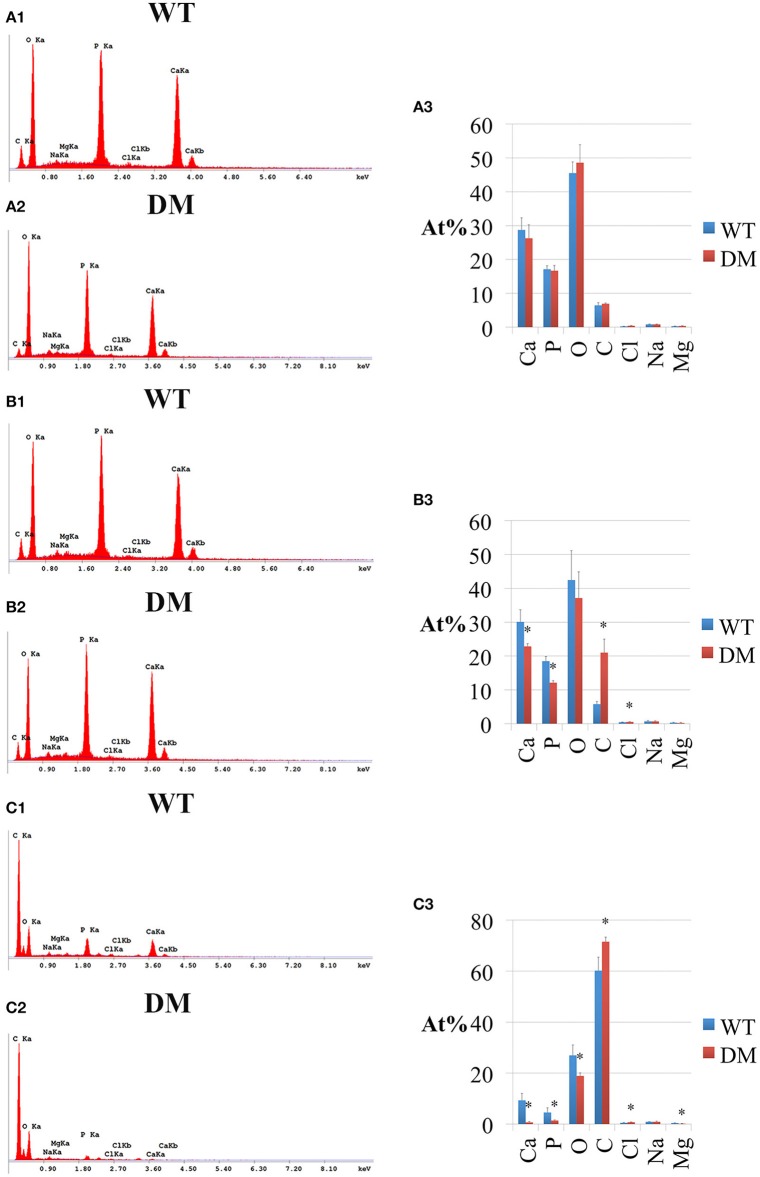
EDS analysis of enamel in wild-type and double-mutant mandibular incisors. WT, Wild-type; DM, Double-mutant; At%, Atomic percentage. (A1,A2) EDS spectrum of enamel at the first reference plane. (A3) Between wild-type and double-mutant enamel at the first reference plane, there were no statistically significant differences in the atomic percentages (At%) of all the elements analyzed—Ca, P, O, C, Cl, Na, and Mg. (B1,B2) EDS spectrum of enamel at the second reference plane. (B3) Statistically significant changes were detected in the At% of Ca, P, C, and Cl. The At% of Ca and P in double-mutant enamel decreased by ~26.7 and ~35.1%, respectively, compared to those in wild-type enamel. There were increases in the At% of C and Cl— ~268.4 and ~18.6%, respectively (double-mutant/wild-type). (C1,C2) EDS spectrum of enamel at the third reference plane. (C3) Double-mutant enamel showed significantly lower At% of Ca, P, O, Mg (~92.8, ~69.2, ~29.6, and ~57.9%), and higher At% of C and Cl (~20.0 and ~35.6%).